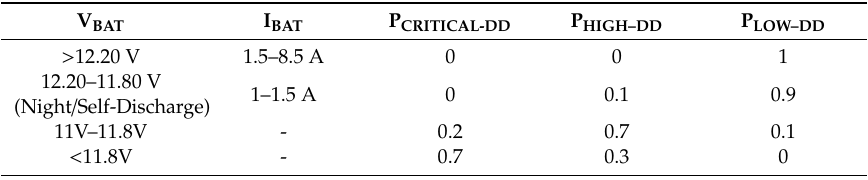
Table 6. Probabilities and possible states for discharge